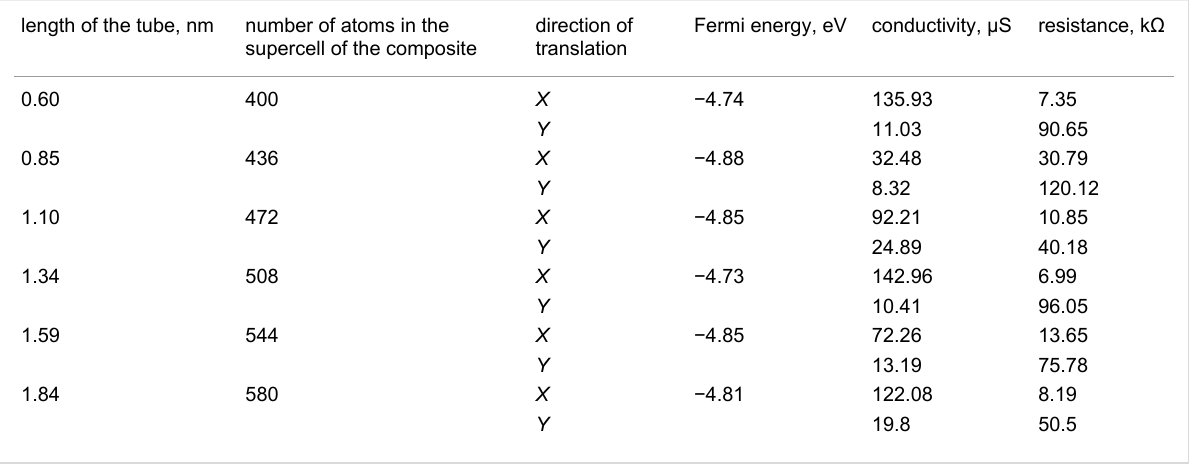
Table 1: Data of investigated single-layer composite films and the results of modelling. length of the tube,